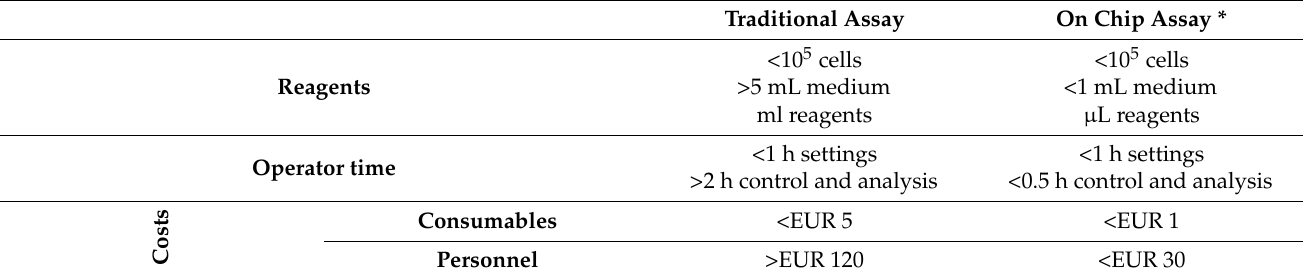
Table 1. Comparison among traditional and on chip assays in terms of estimated reagents consumption, operator time, and assay